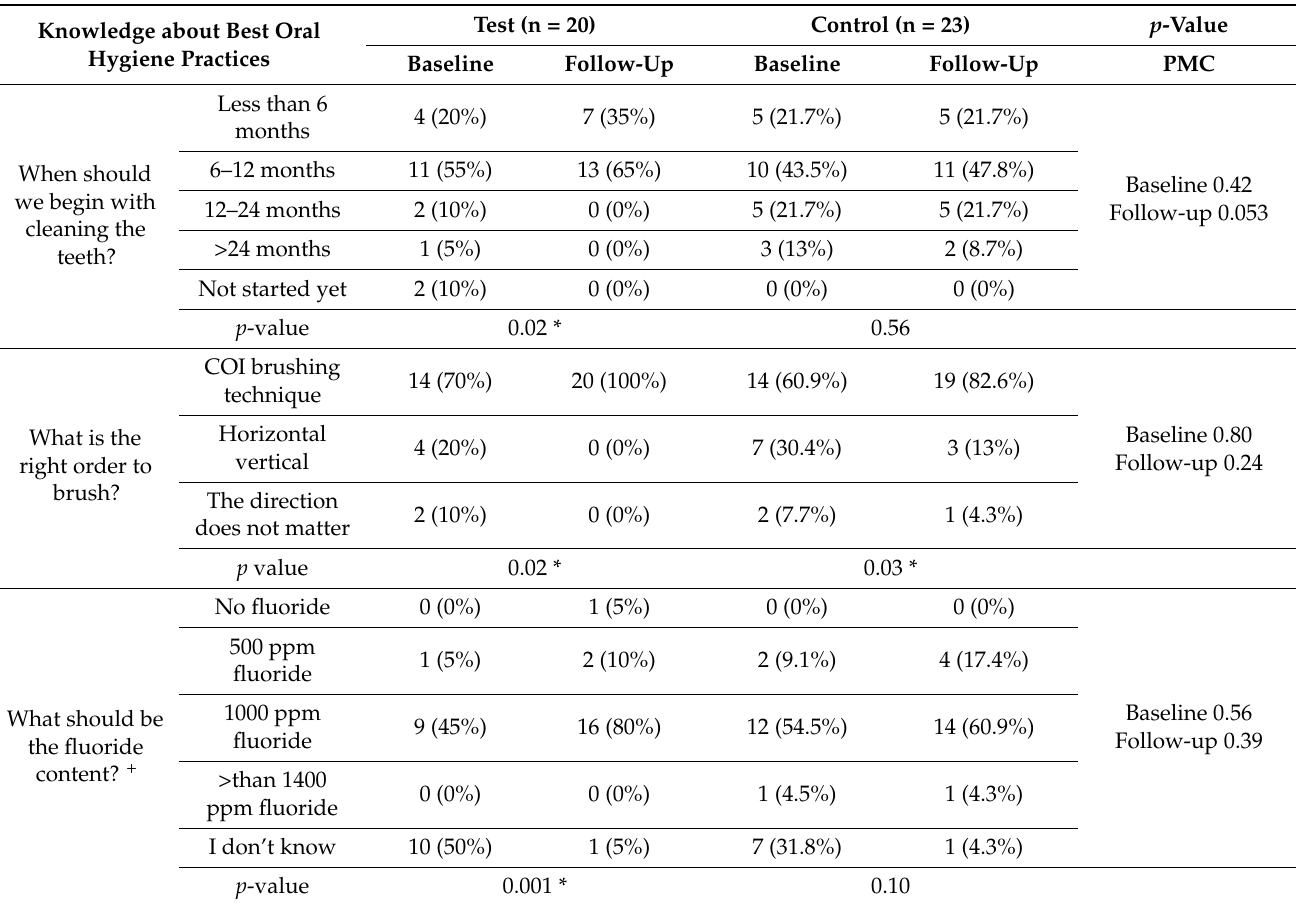
Table 4. Knowledge about the best oral hygiene practices at baseline and follow-up.